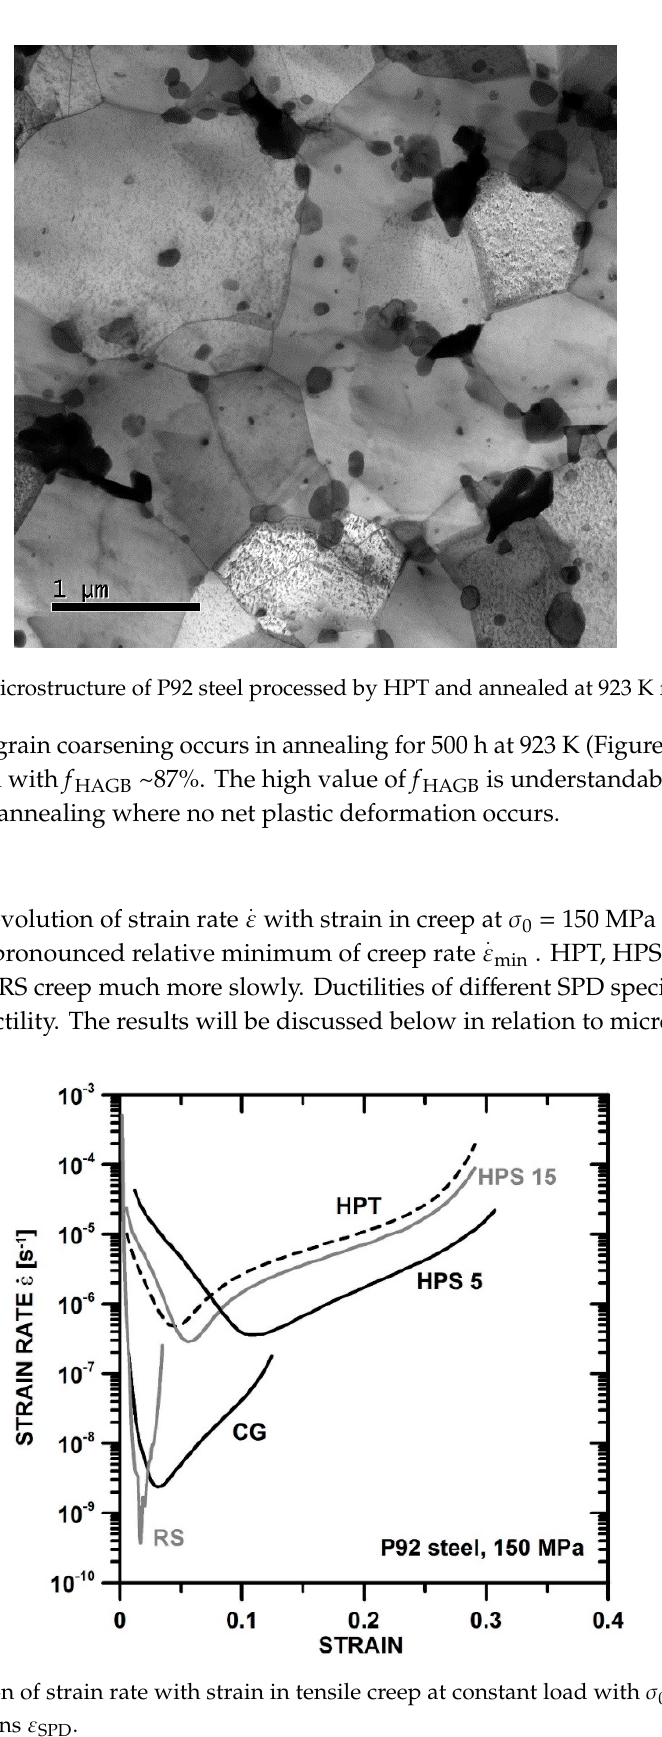
Figure 4. Microstructure (TEM) after annealing at 873 K for 5 h in ( a ) RS, ( b ) HPS5, ( c ) HPS15, and ( d ) HPT; note the higher magnification in ( c , d ).